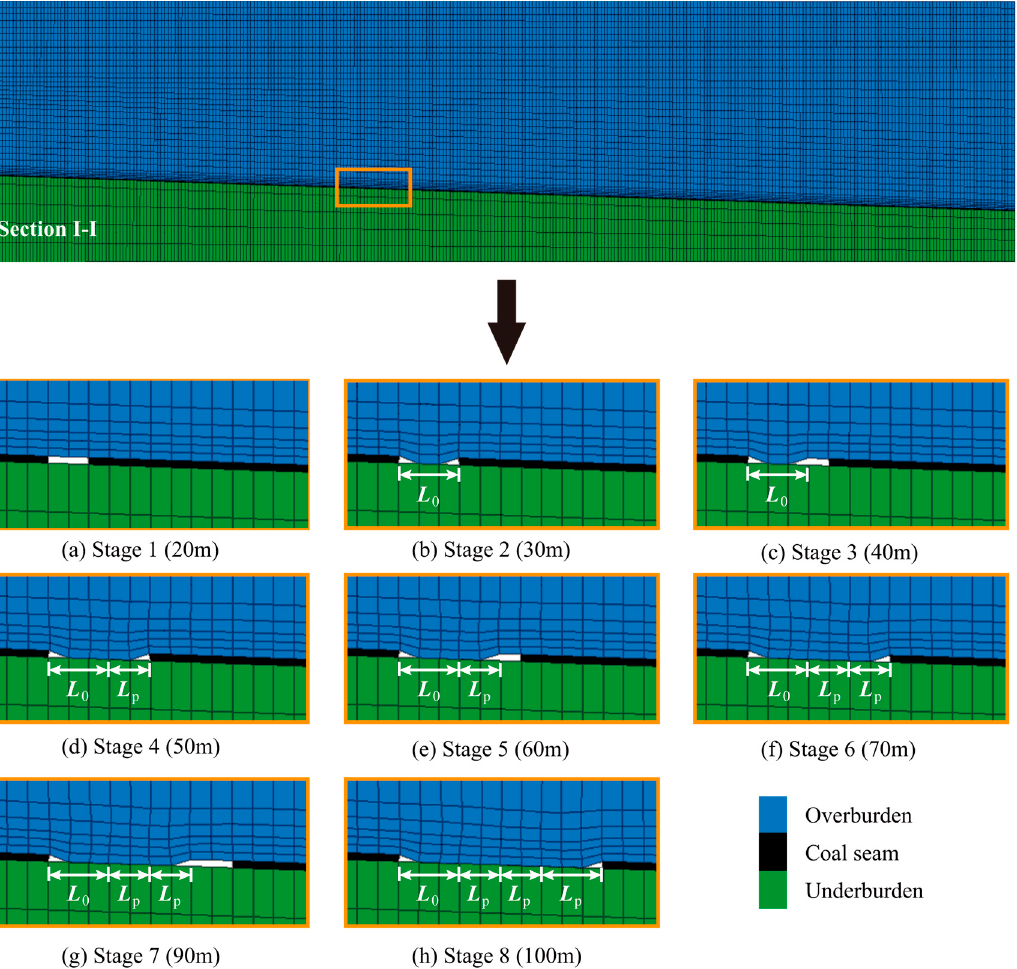
Figure 13. Simulated progressive caving of the overlying strata due to excavation.